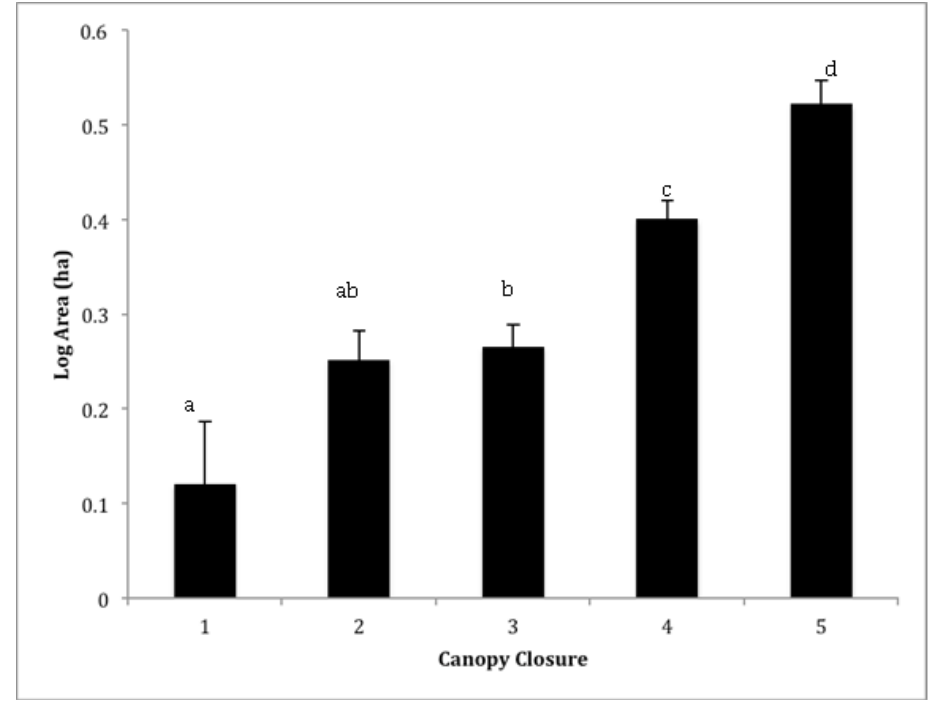
Figure 3. Mean (±SE) log area (ha) of sacred groves within each canopy closure category: 1 (<25%), 2 (25–50%), 3 (50–75%), 4 (75–90%) and 5 (>90%). Lowercase letter